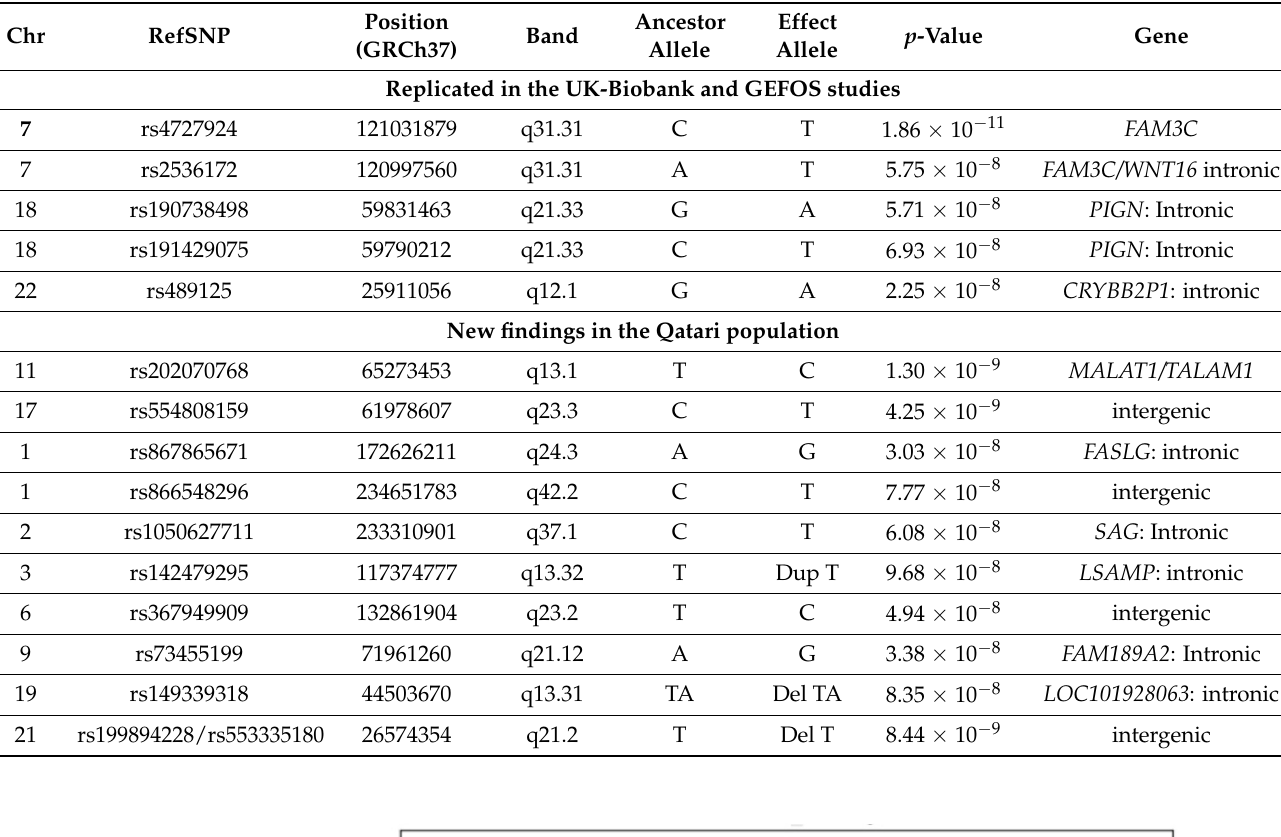
Table 4. Genome-wide significant total body bone mineral density variants.